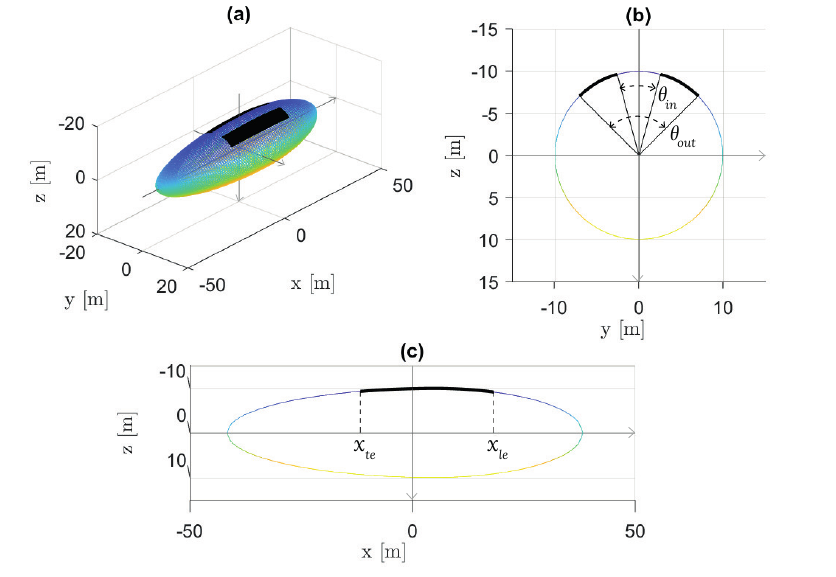
Figure 1. Modeling approach for the geometry of solar cells. ( a ) 3-D view. ( b ) y - z plane view. ( c ) x - z plane